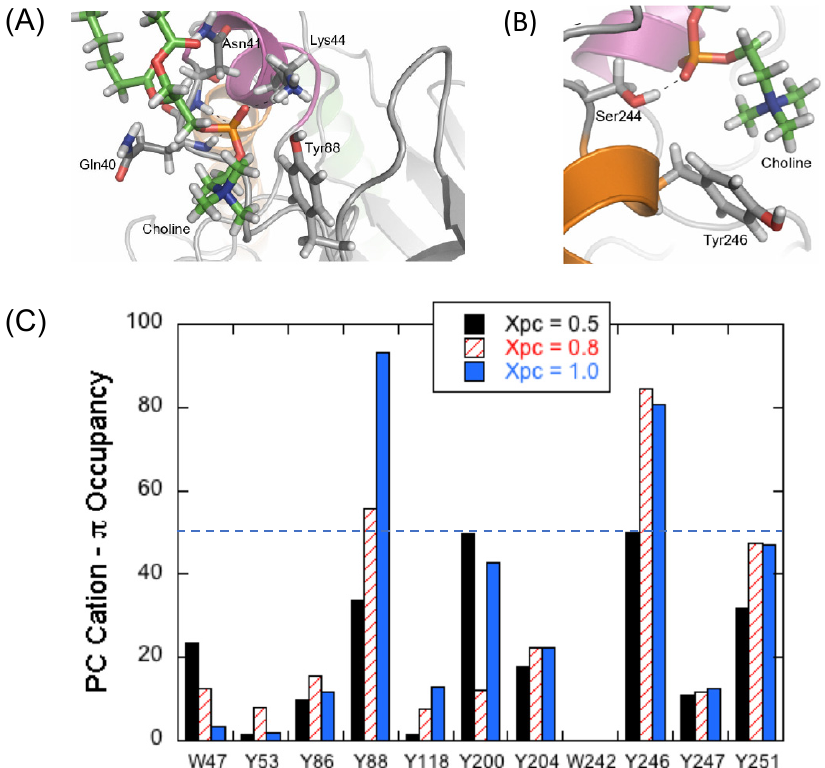
Figure 6. Occupancy of PC cation–Tyr- π complexes identified in MD simulations depends on X PC . Snapshots of cation- π interactions at X PC = 1 for ( A ) Tyr88 and ( B ) Tyr246 (representative frames taken between 400 and 500 ns). ( C ) Occupancy of cation- π sites as a function of X PC . Both ( A , B ) are reprinted with permission from Grauffel et al., J. Am. Chem. Soc. 2013, 135, 5740–5750. Copyright 2013, American Chemical Society.